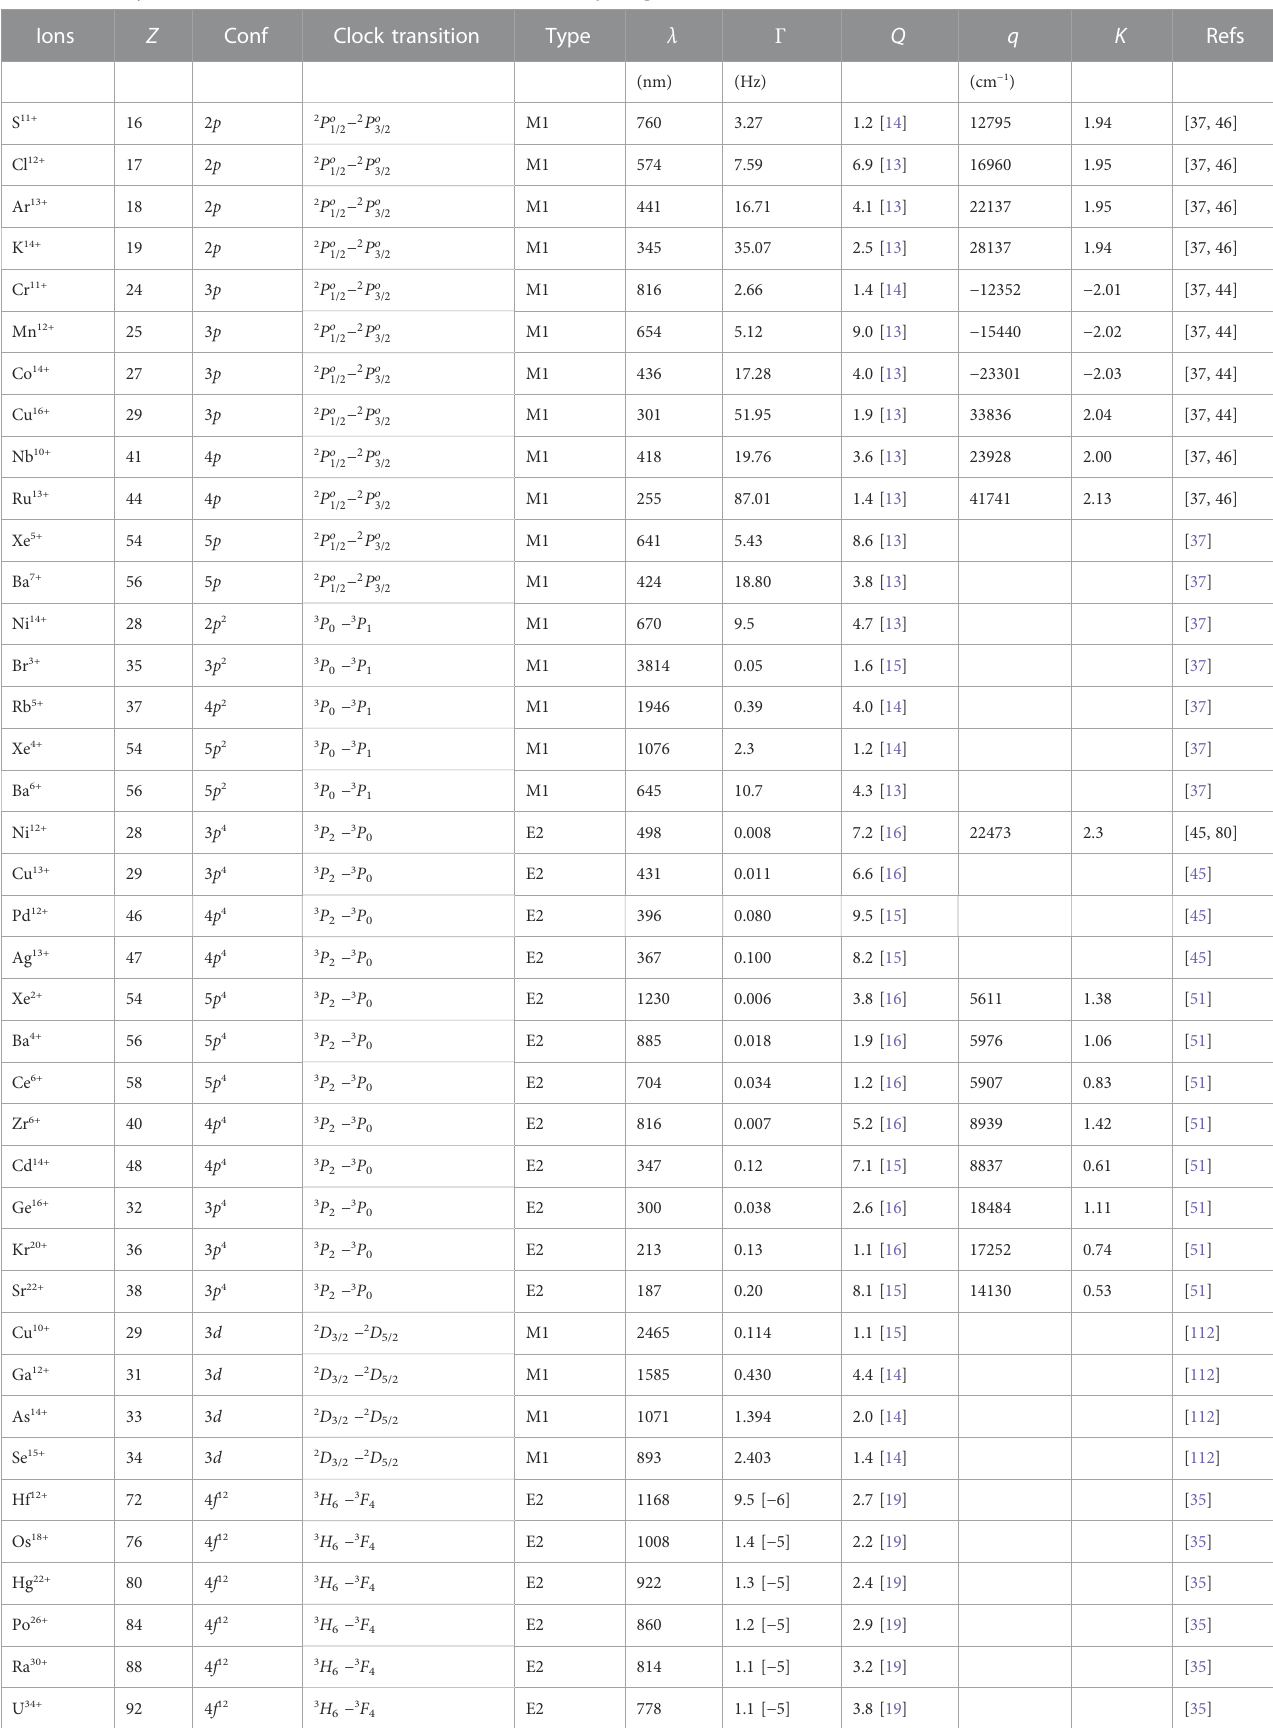
TABLE 5 Summary of selected M1 and E2 HCI transitions of fi ne-structure splittings. a [ b ] should be read as a × 10 b .